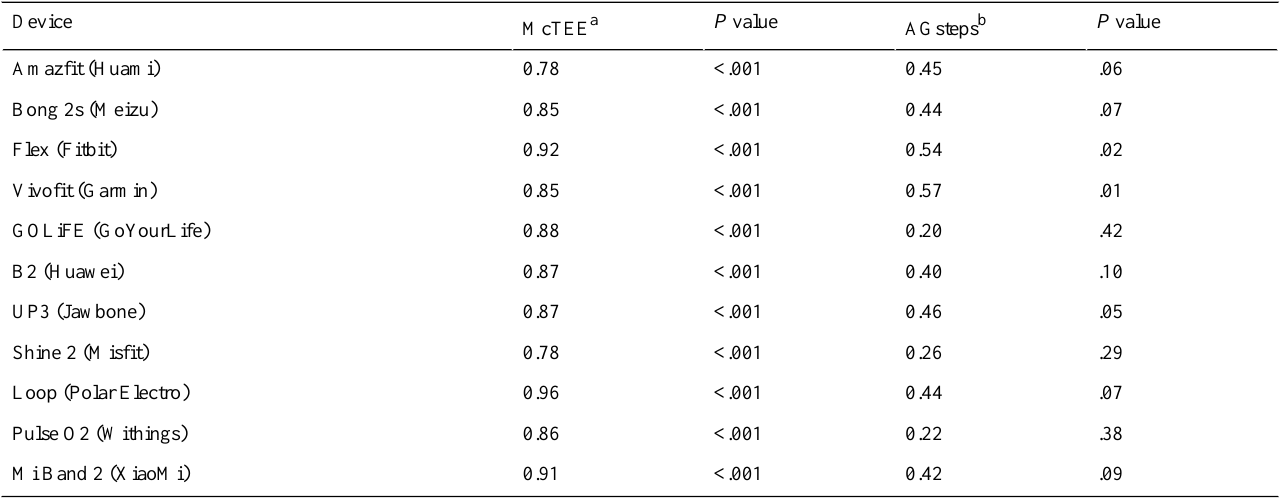
Table 3. The Pearson correlation coefficient between wrist-wearable activity devices and criterion measures for total energy expenditure (kcal) and step counts.